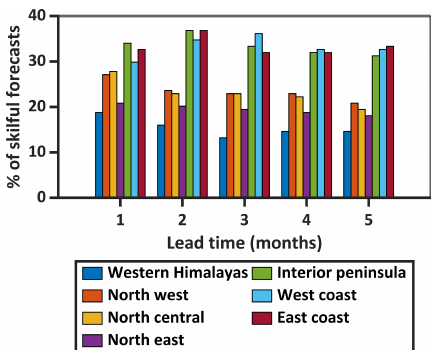
Figure 6. Forecast performance for homogenous regions at different lead